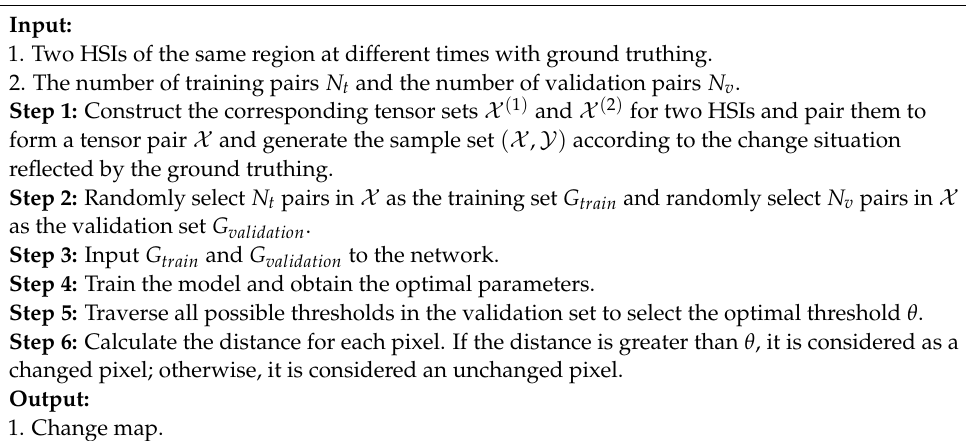
Algorithm 1: Algorithm of SSCNN-S for hyperspectral image (HSI) change detection (CD).